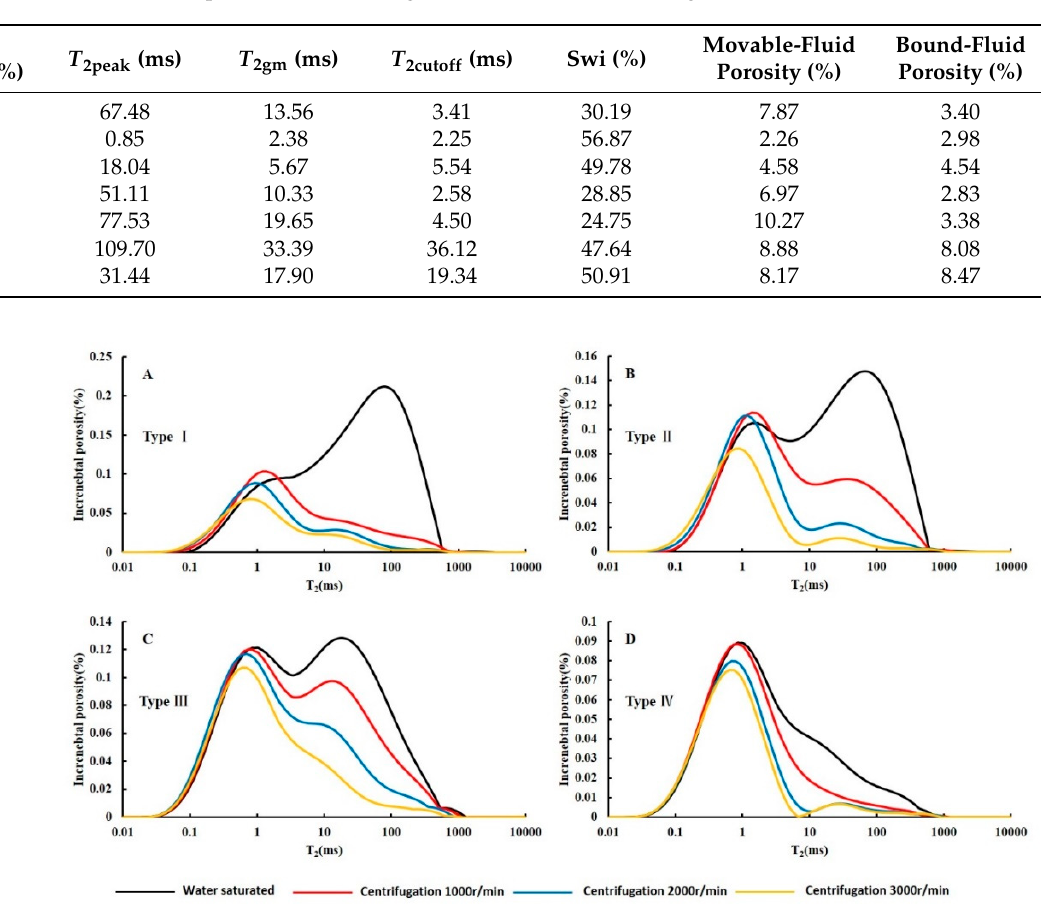
Table 4. Water saturation of samples at different centrifugal speeds. Table 3. NMR parameters of E 3 h tight sandstones in in Xihu Sag.